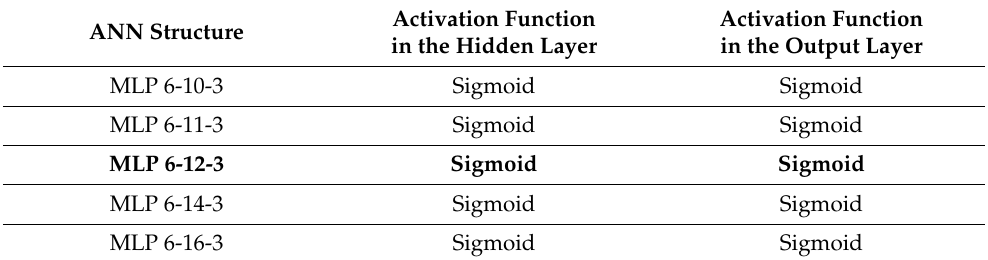
Table 1. The best MLP network models for MdP assessment.